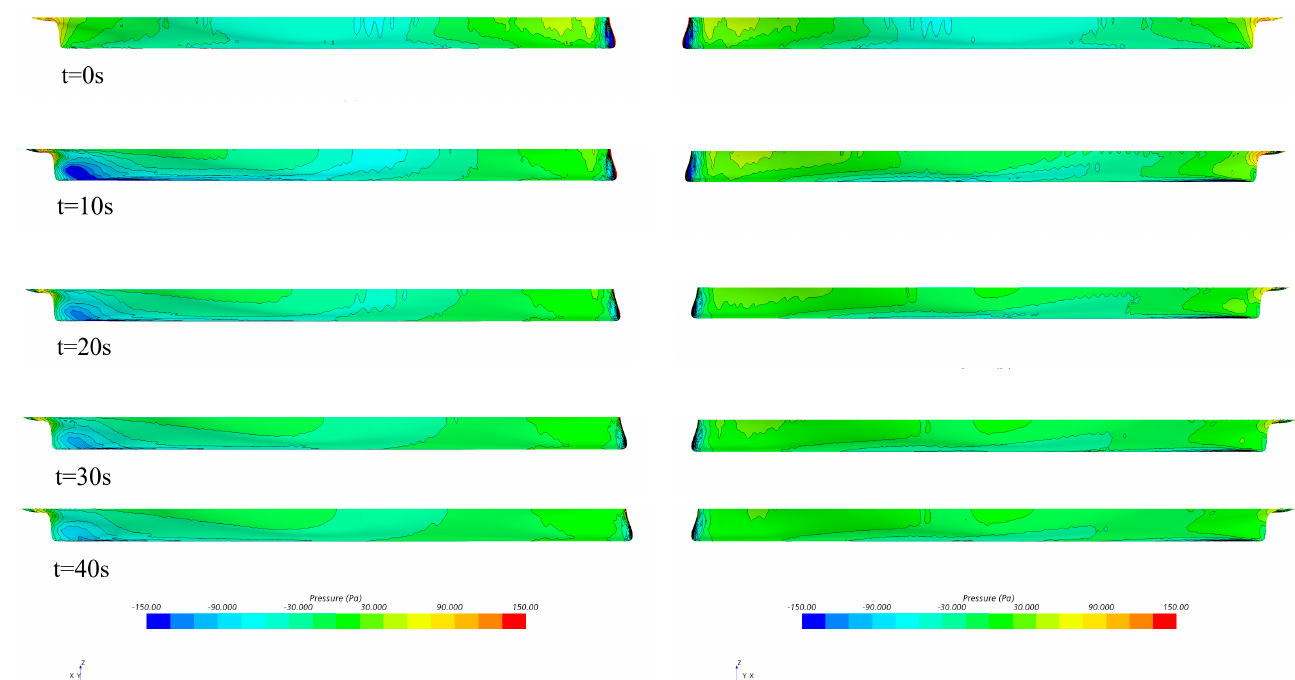
Figure 20. Pressure change on hull’s surface during transition phase.